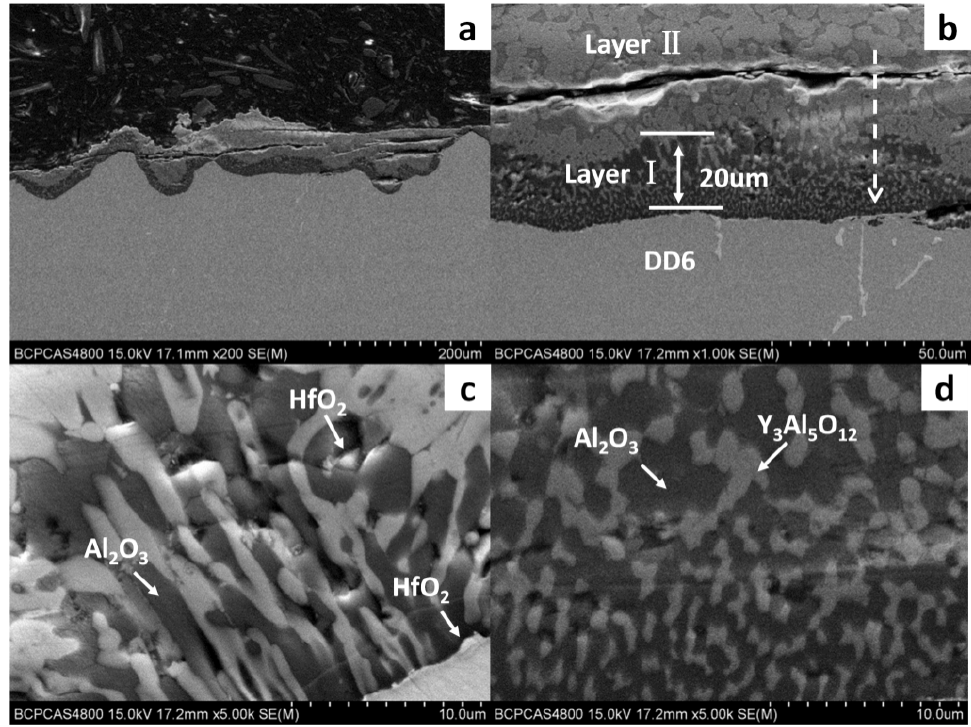
Figure 2. The interfacial reaction between DD6 and Y 2 O 3 mould: ( a ) cross-Section of alloy; ( b – d ) high magnification.